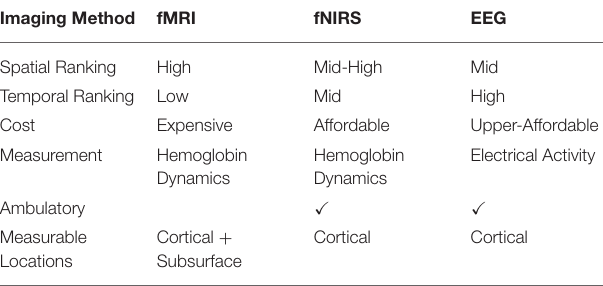
TABLE 1 | Summary of popular brain imaging techniques.